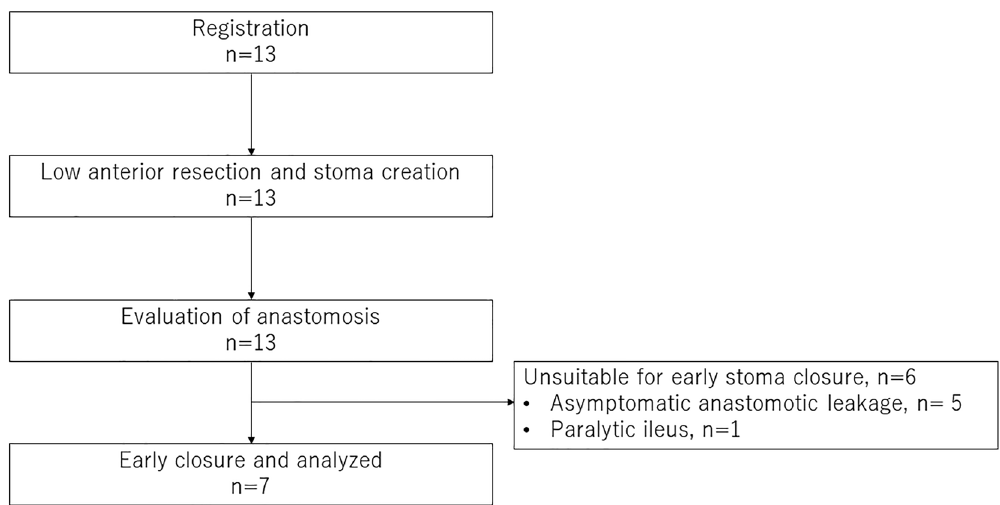
Figure 1. Recruitment and clinical course. Thirteen patients participated in this study. After planned surgery, all patients underwent an evaluation of colorectal anastomosis. Six patients did not receive early stoma closure due to suspected leakage (n = 5) or paralytic ileus (n = 1). Seven of the 13 patients underwent early stoma